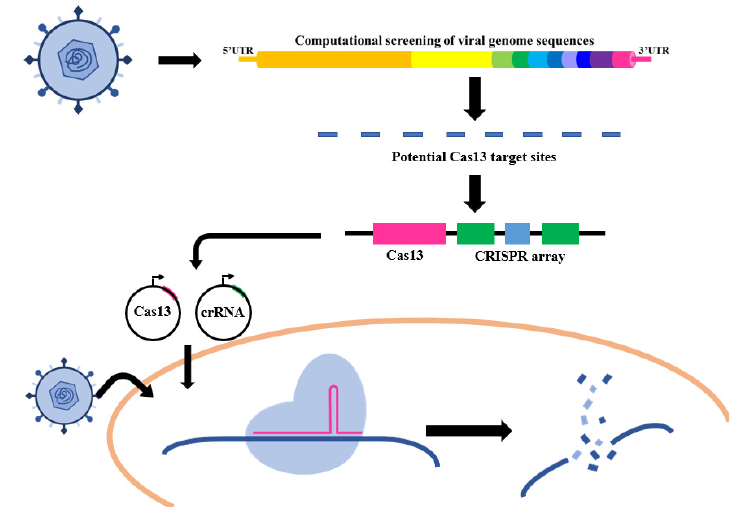
Figure 4. Strategies based on the CRISPR ‐ Cas system for anti ‐ RNA viruses.